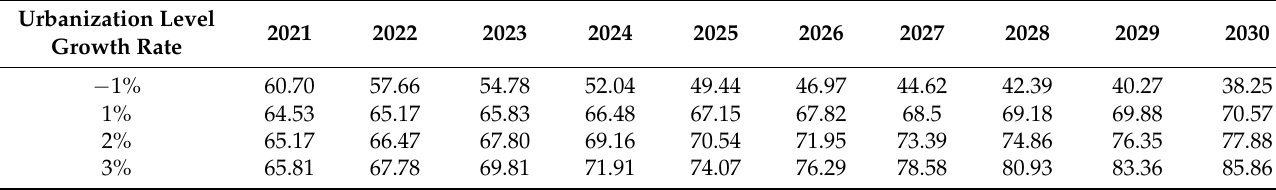
Table 7. Urbanization level under different growth rates.